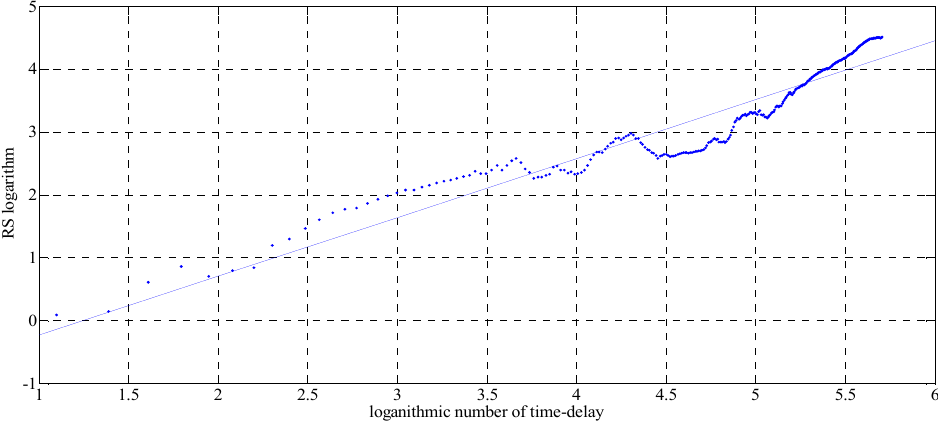
Figure 3. Hurst parameter of the time delay